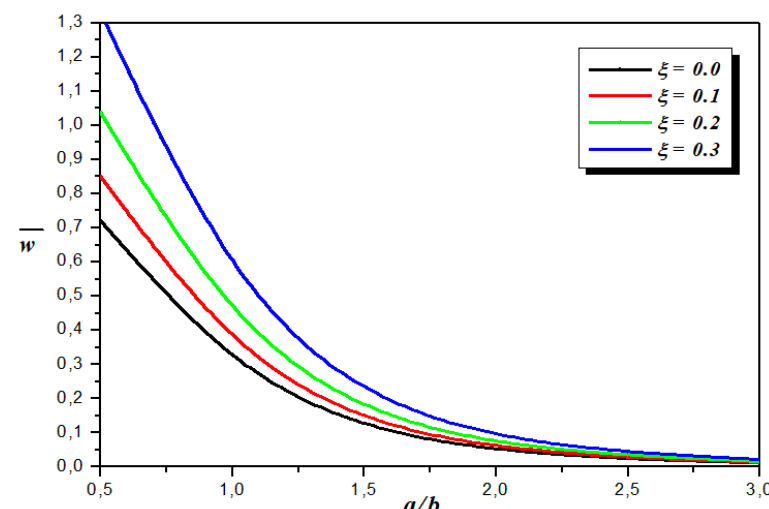
Figure 4: Displacement variance as a geometric ratio feature (a / b) for different porosity factor values ( ξ ).